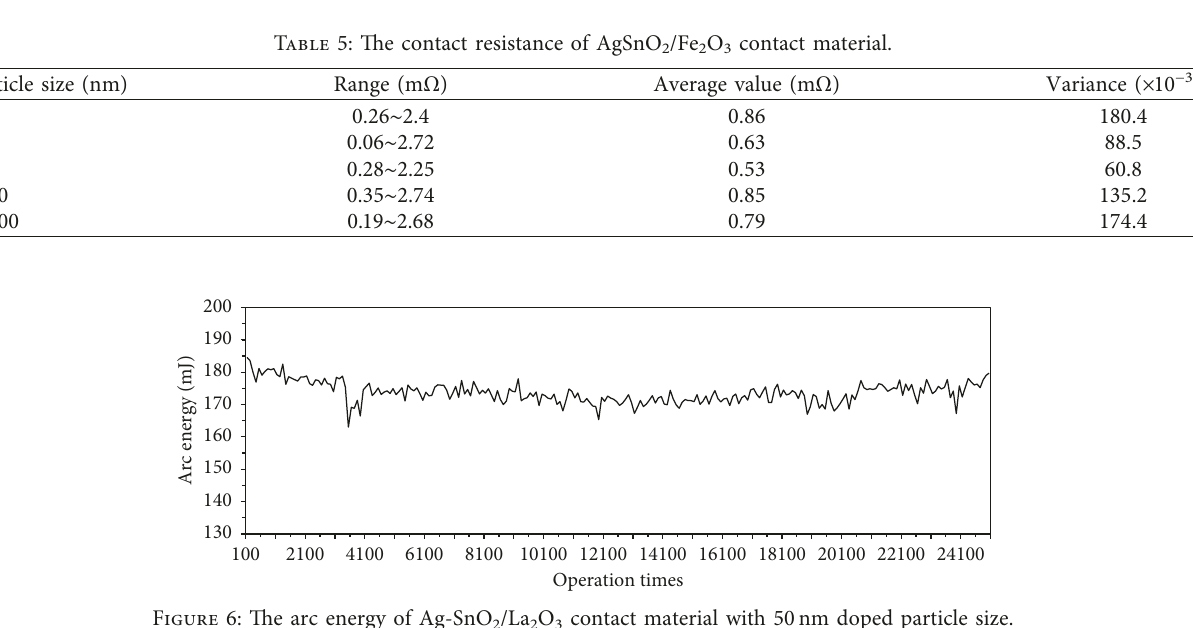
Table 5: The contact resistance of AgSnO